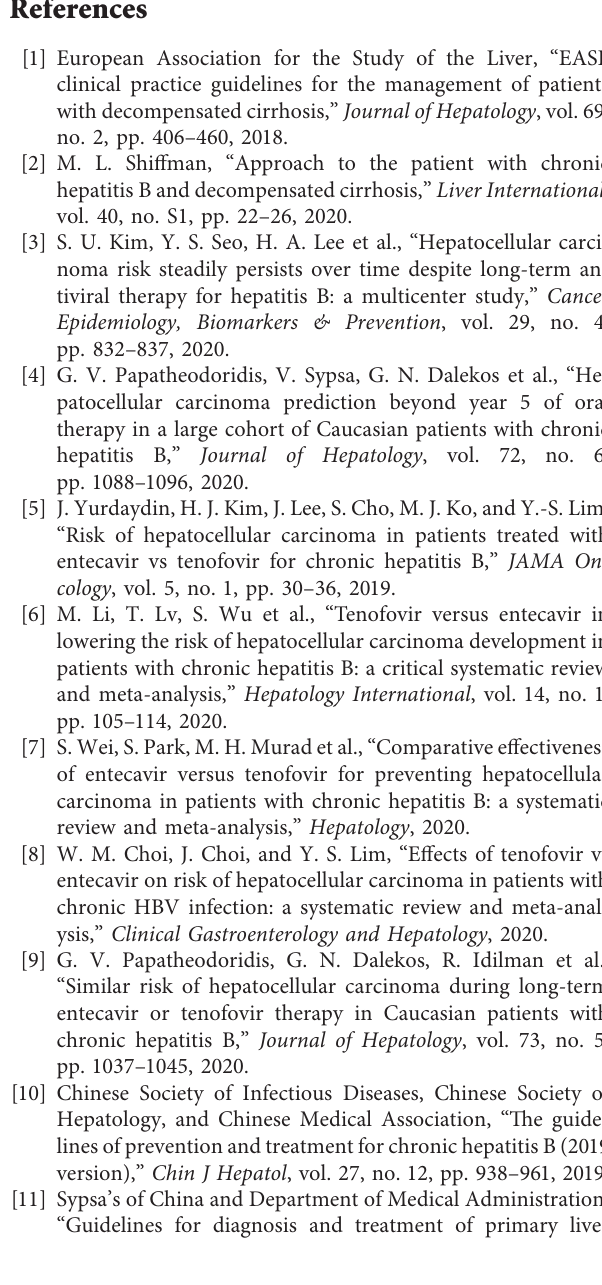
Supplementary table. Baseline characteristics of patients with decompensated Cirrhosis. ( Supplementary Materials )